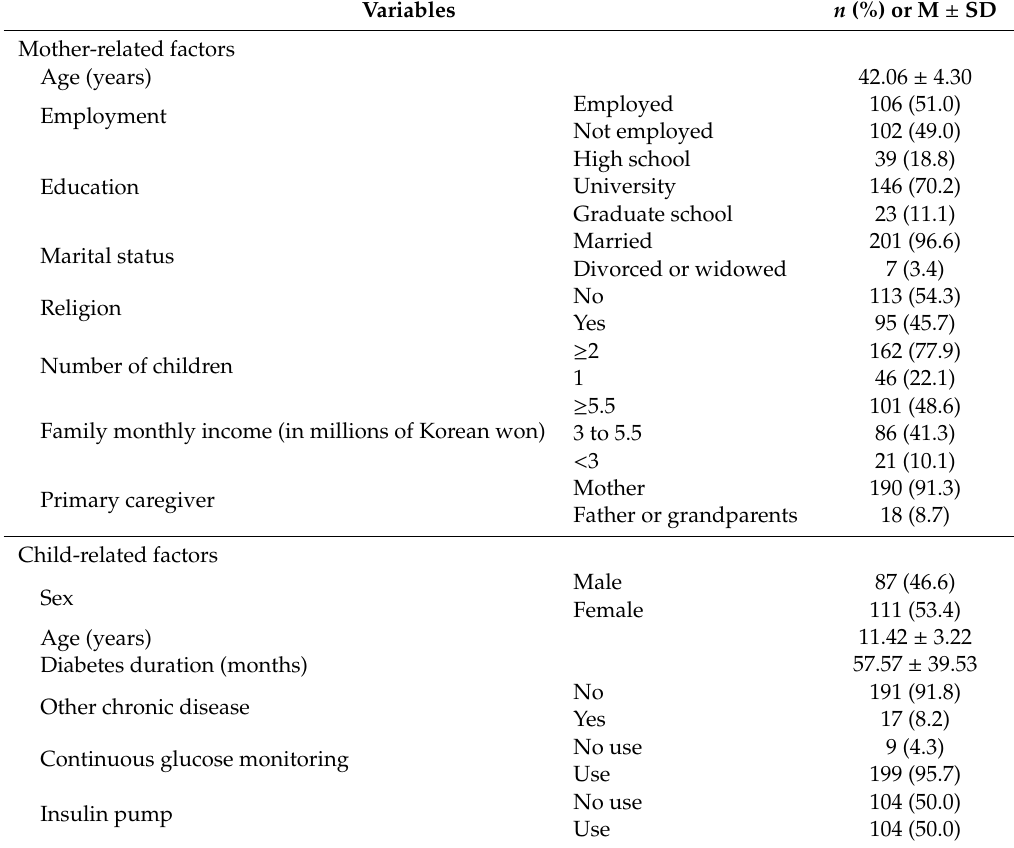
Table 1. Demographic characteristics ( N =